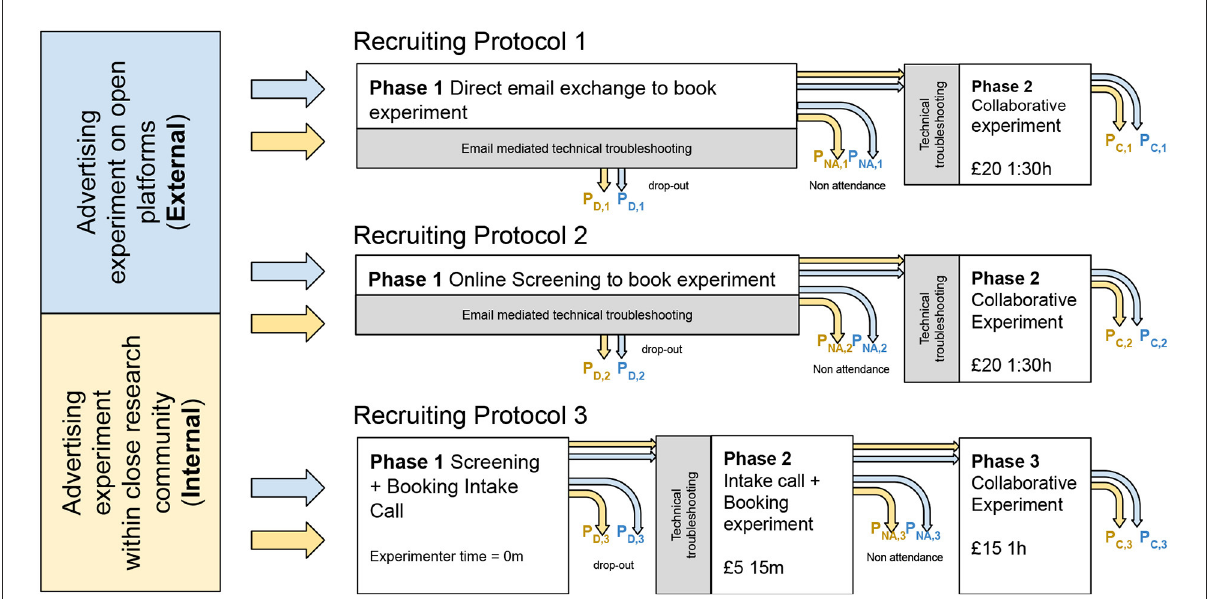
FIGURE1 This figure shows the different phases of the three recruiting protocols. Each protocol occupies a row and contains phases that the participants can pass or not. Yellow elements (labels, arrows) refer to the close research community population (internal). Light-blue elements refer to participants hired with open platforms (external). Both protocols were used to recruit from both external/internal